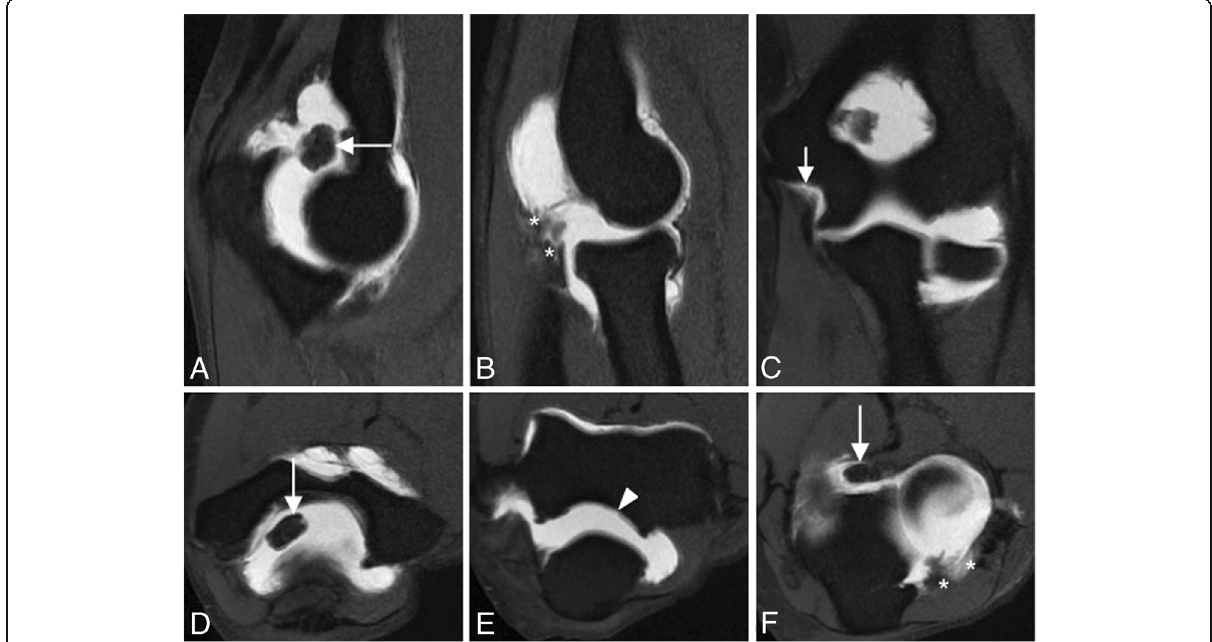
Fig. 3 Sagittal FS T1-weighted direct MR arthrographic images ( a , b ), coronal FS T1-weighted direct MR arthrographic image ( c ), and axial FS T1- weighted direct MR arthrographic images ( d – f ) showing a proximal partial-thickness proximal tear of the anterior bundle of the medial collateral ligament complex (short arrow), disruption and stripping of the posterior and lateral capsular structures (white asterisks), intra-articular bodies (long arrows), and full-thickness defect at the posterior joint line (arrowhead). Note ulnohumeral incongruity ( a ) and radiocapitellar incongruity ( b )